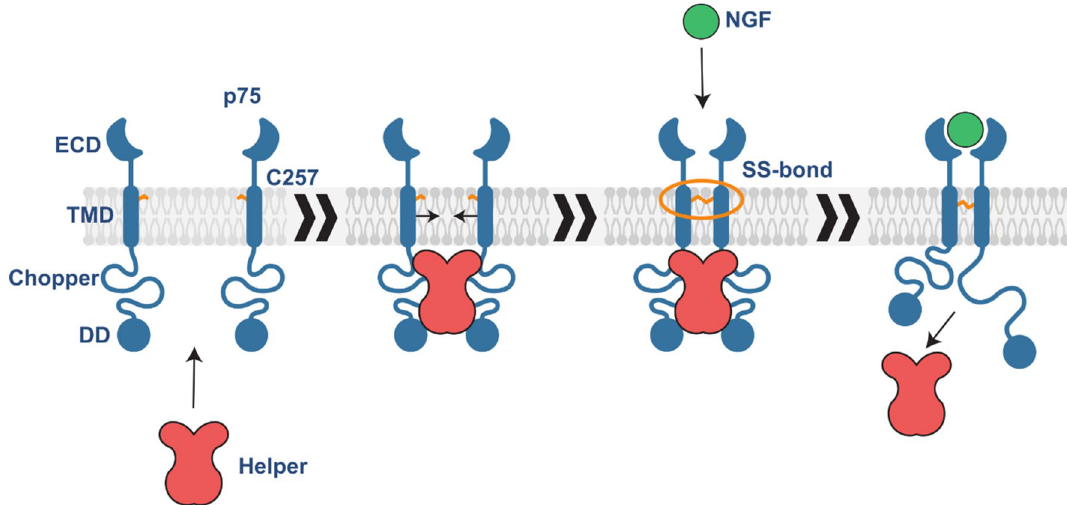
Figure 9. The mechanism of p75NTR dimerization and activation upon the ligand binding. Schematic representation of p75NTR covalent dimer formation in membrane by “helper” protein and receptor activation in response to neurotrophin binding. The figure was prepared using the program Inkscape 0.92 (https ://inksc